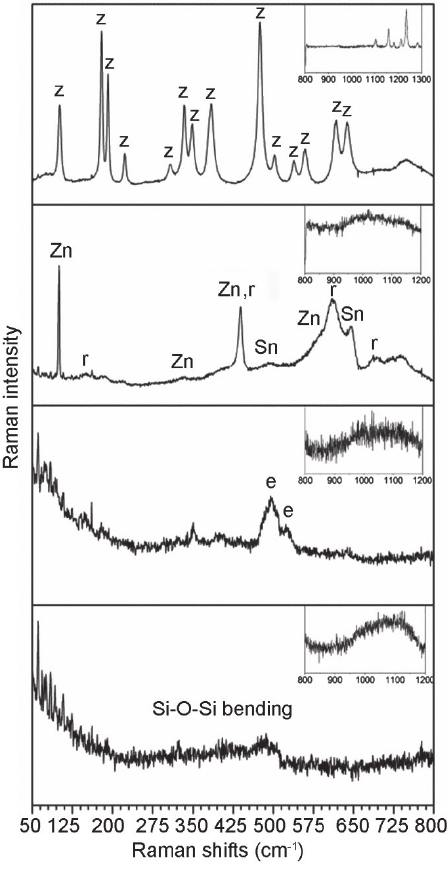
Figure 2 Raman spectra from the surface of dental porcelain specimens.